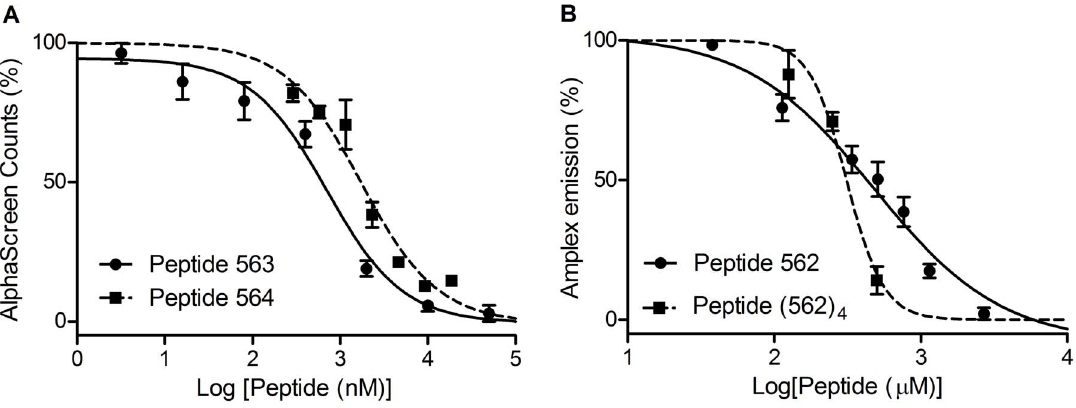
Figure 5. Evaluation of binding affinities between phage display-discovered peptides and PSMA. ( A ) AlphaScreen assay in which Peptide 563 (filled circles) or Peptide 564 (filled squares) competed with biotinylated peptide 563 for binding to PSMA. Data was fitted to generate IC 50 curves for Peptide 563 (solid line) and Peptide 564 (dashed line). ( B ) Fluorescence-based PSMA enzyme inhibition assay in which Peptide 562 monomer (filled circles) or Peptide 562 tetramer (filled squares) inhibited the hydrolysis of NAAG (substrate) by PSMA. Data was fit to generate IC 50 curves for Peptide 562 monomer (solid line) and Peptide 562 tetramer (dashed line).